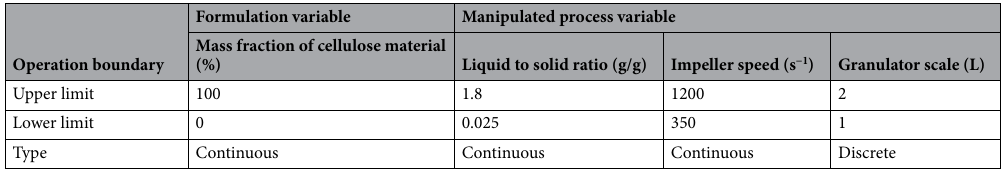
Table 1. Factors and limits in the experimental